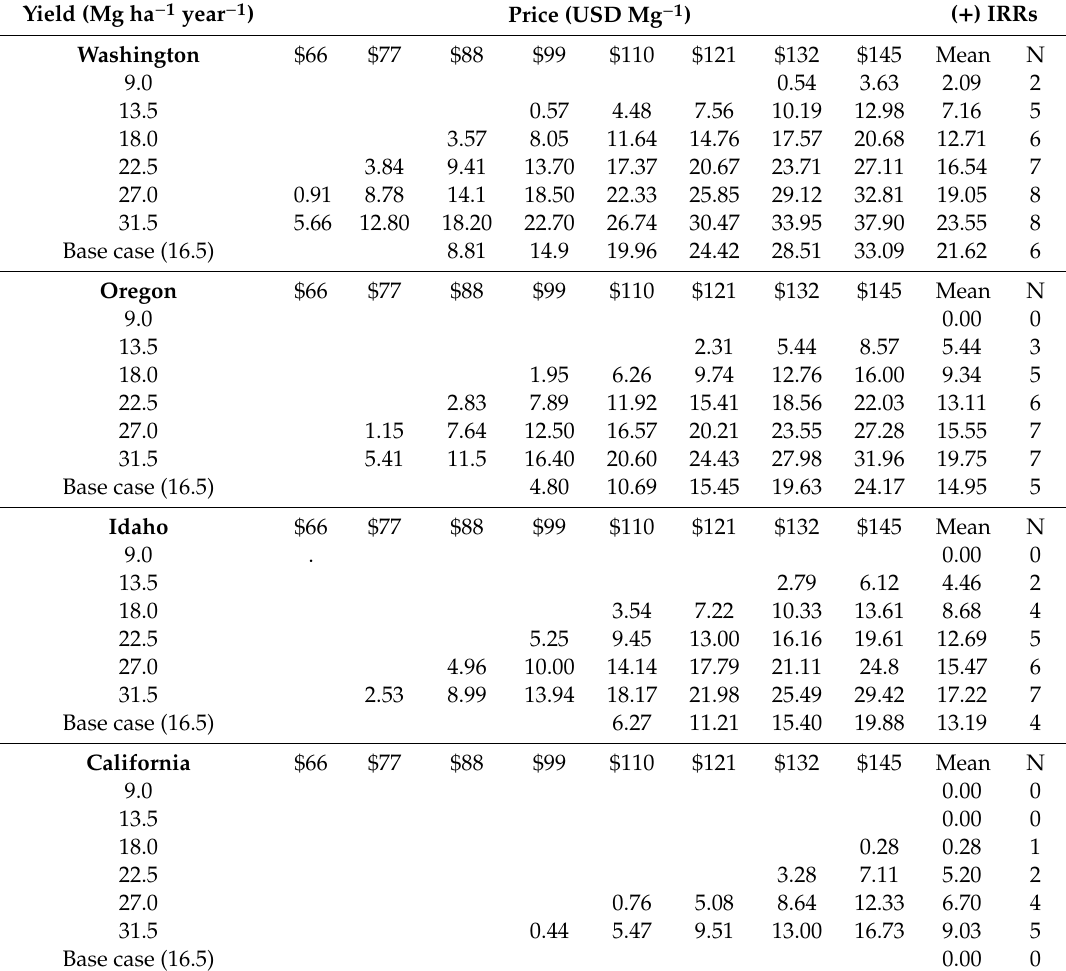
Table 7. Internal rates of return (%) as a function of yield and market pricing 1